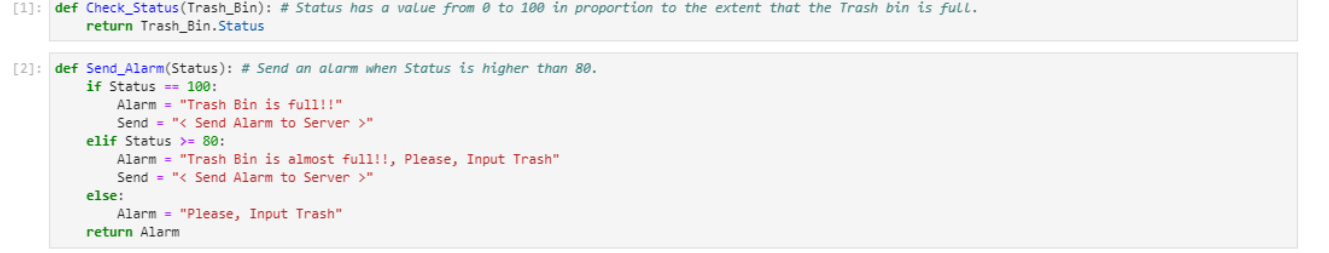
Figure A2. Define Check Status and Send Alarm Process using Python pseudocode.